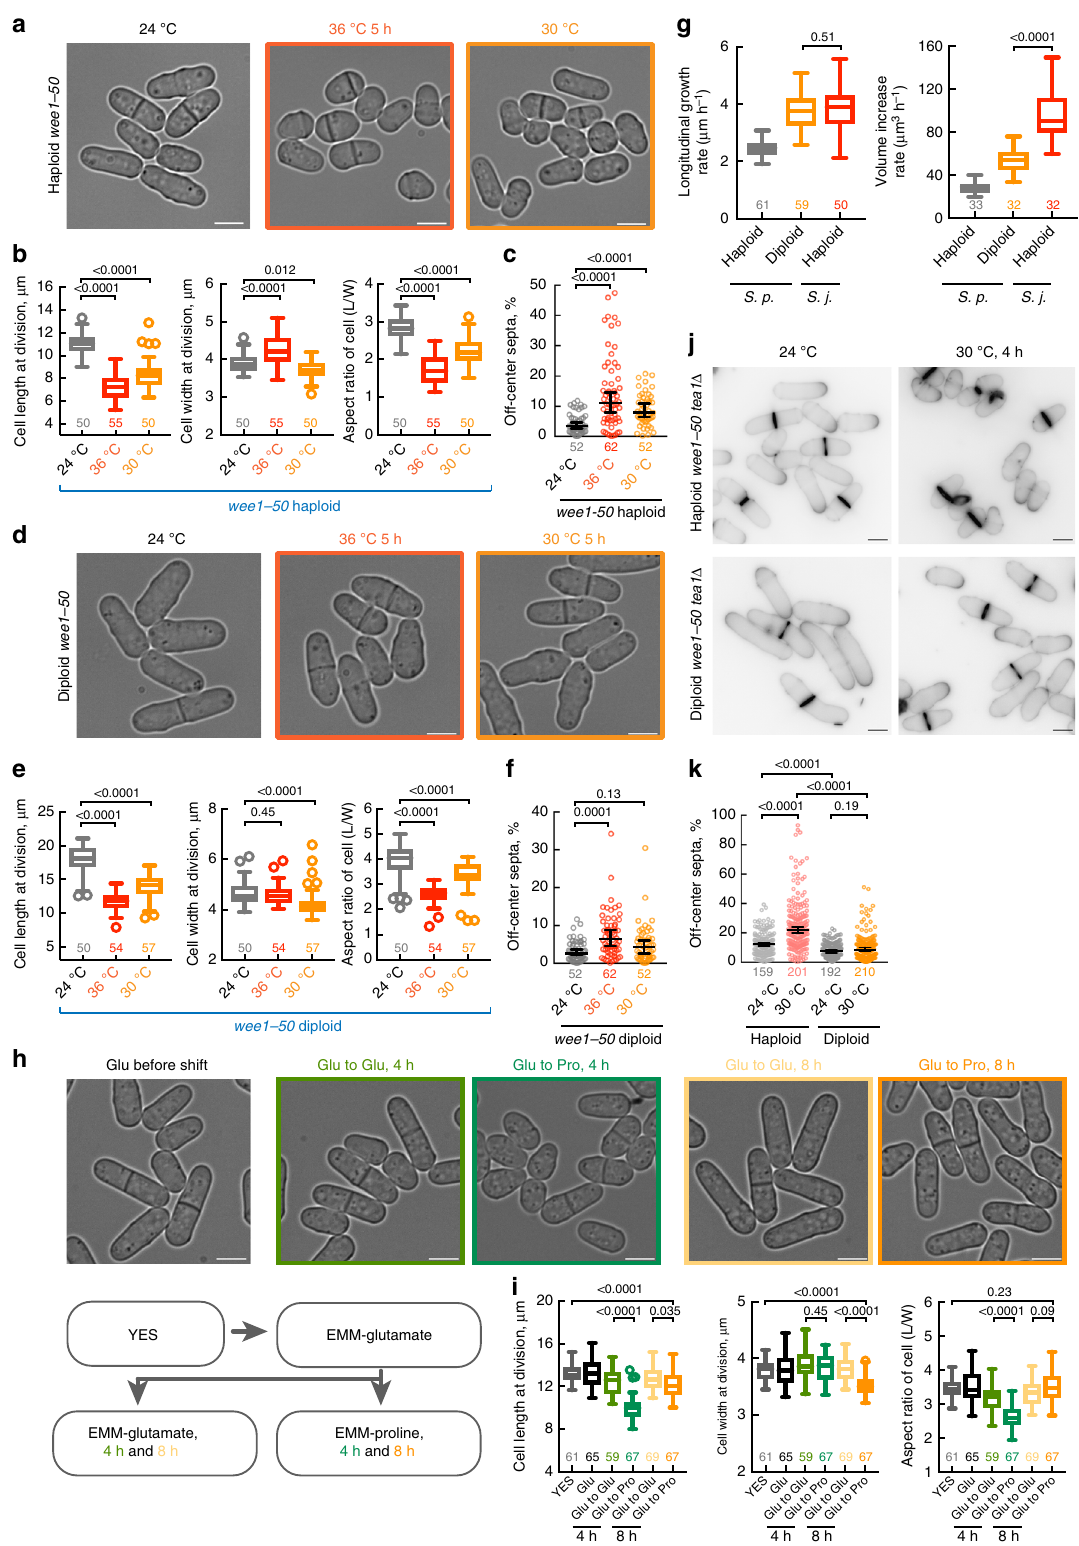
growth and an increase in the cell diameter 45 . In line with cellular polarity defects, wee1-50 mutants shifted to 36 °C exhibited fre- quent division site mis-positioning (Fig. 5a, c, see also ref. 34